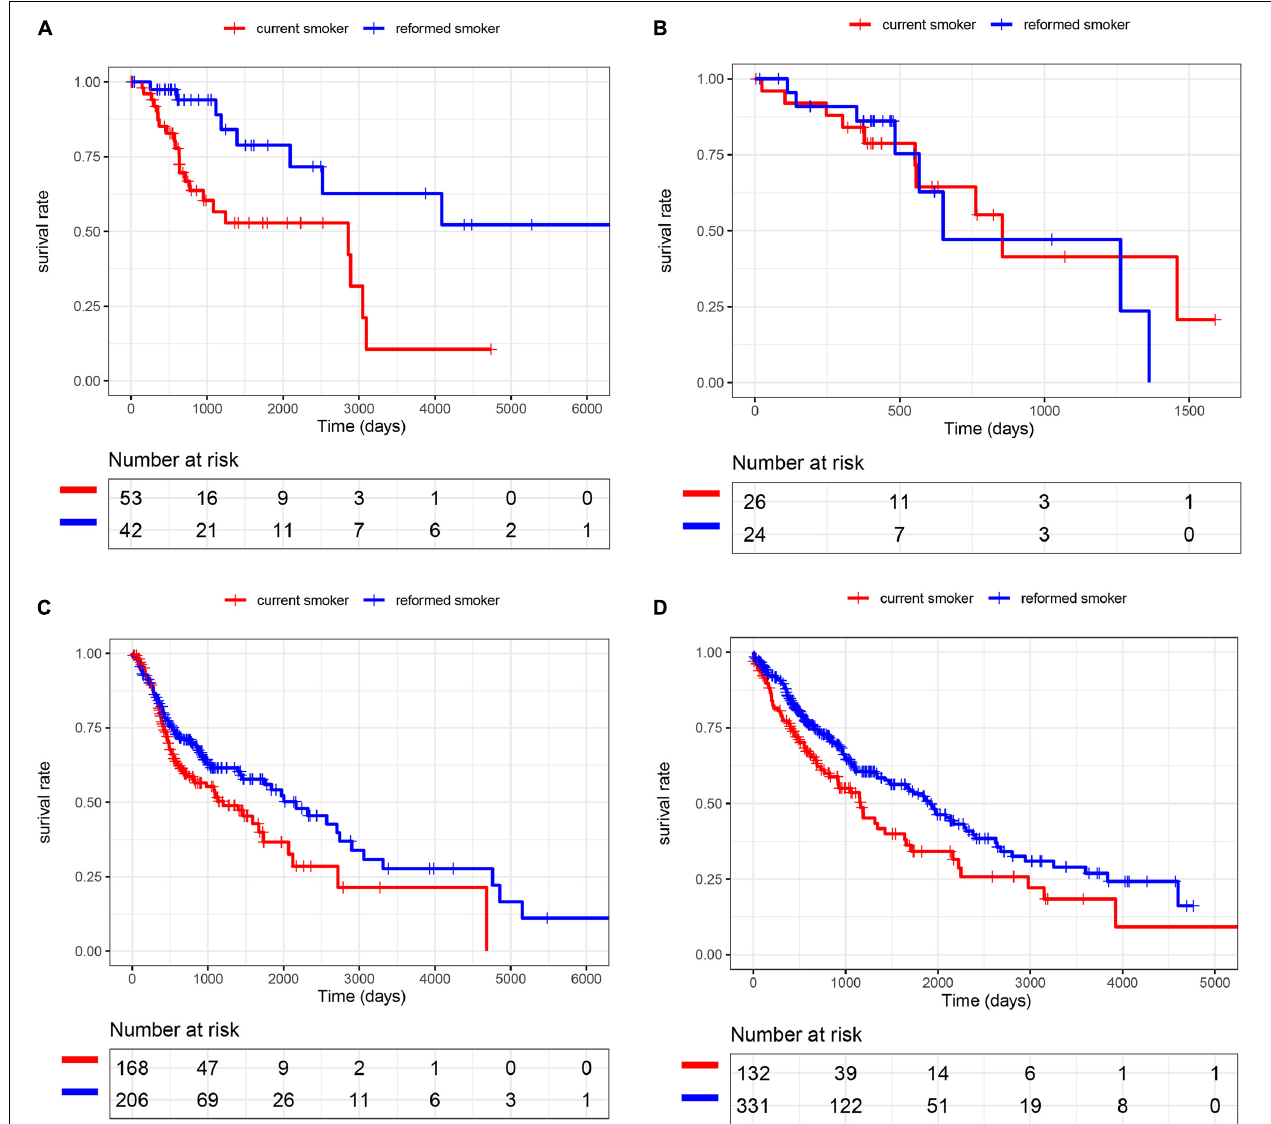
FIGURE 1 | Smoking cessation could improve prognosis in SCC. (A) CSCC. (B) ESCC. (C) HNSC. (D)